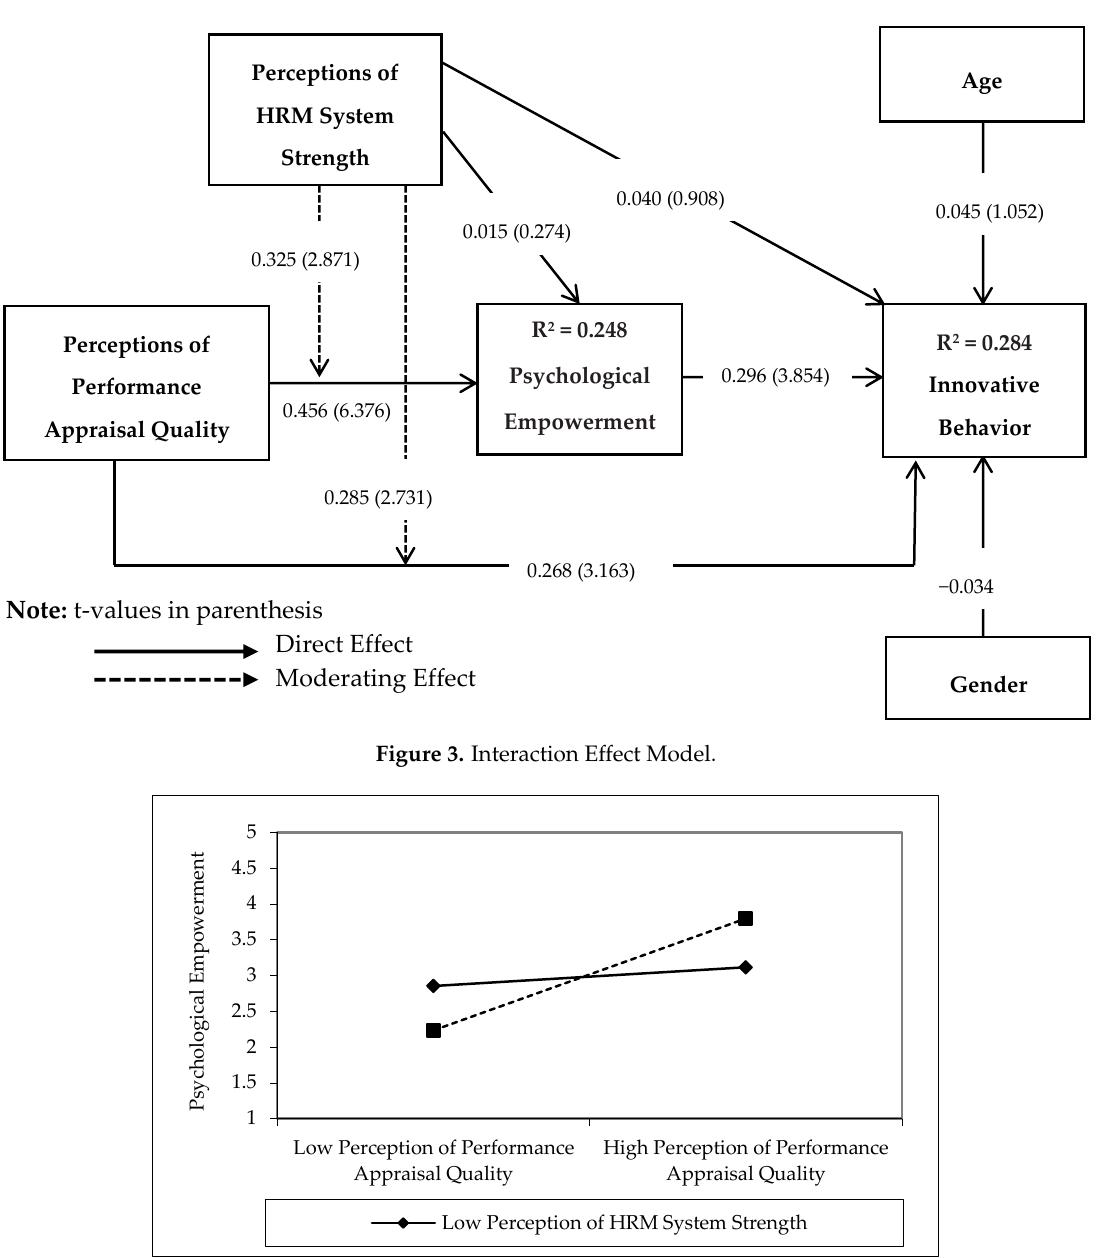
Figure 4. Interaction effect of perceptions of HRM system strength on perceptions of performance appraisal quality and psychological empowerment.